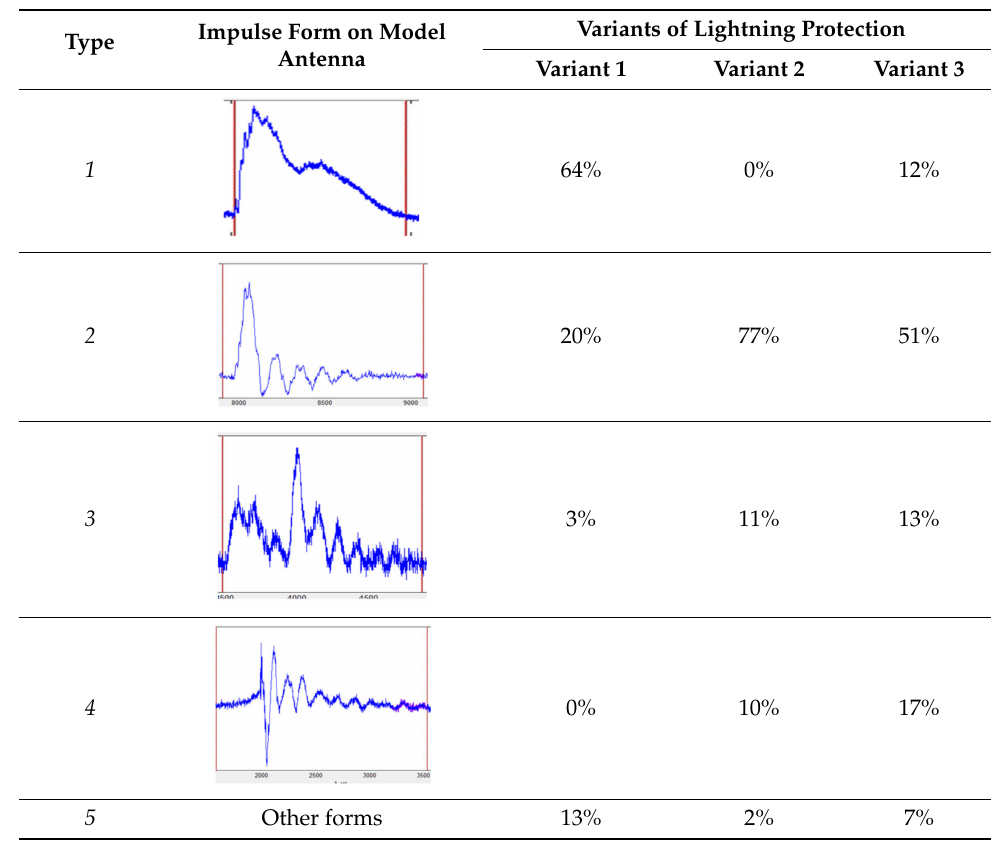
Table 1. Characteristic types of impulses recorded on the antennas under the radome model for various versions of its lightning protection.